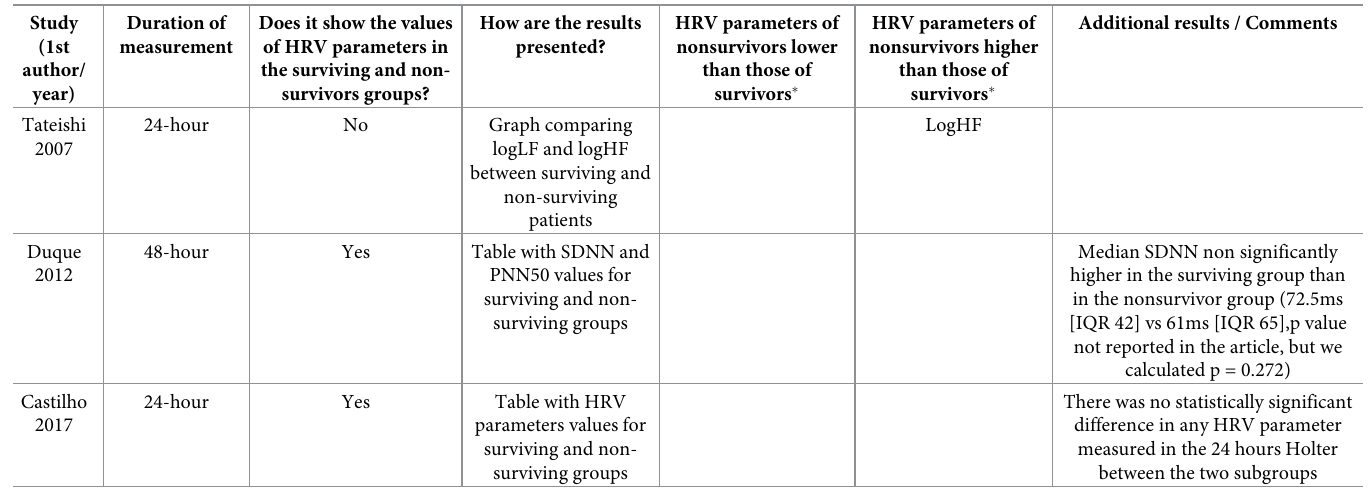
Table 5. Main results in long time record studies.